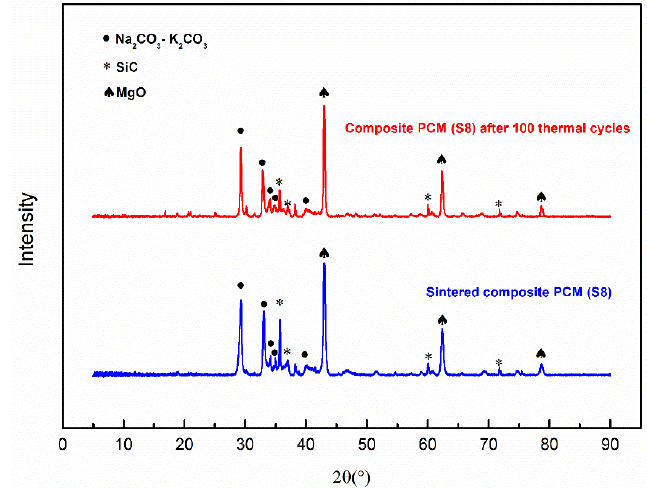
Figure 7. XRD patterns of Sample S8 with and without 100 thermal cycles.